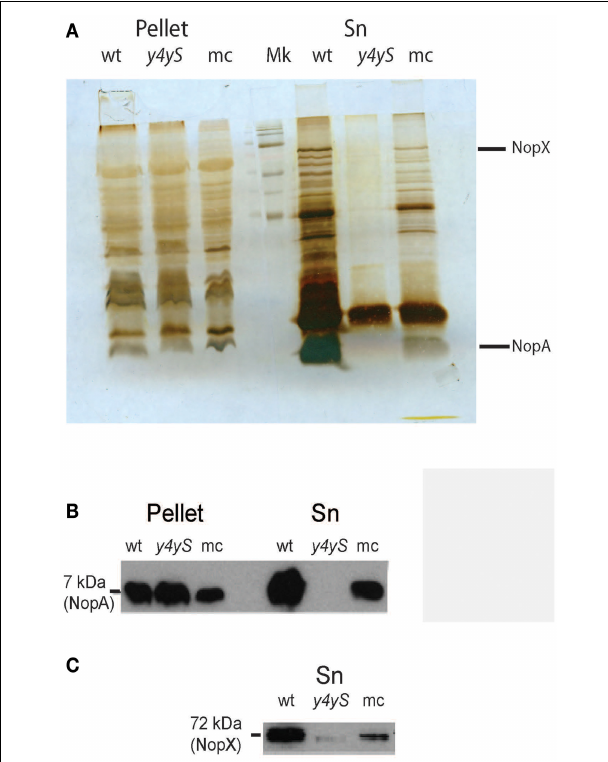
FIGURE 3 | Analysis of T3SS secreted proteins in the wild-type, y4yS mutant, and y4yS mutant complemented strains. Supernatant (Sn) and intracellular proteins (pellet) were isolated from MAFF303099 (wt), its y4yS mutant ( y4yS ), and the mutant complemented with a plasmid of moderate copy number containing the full-length y4yS gene under the lac promoter (mc). Bacteria were grown in T3SS inducing conditions. All bacteria contain plasmid pMP2112. Proteins were separated by 15% SDS-PAGE, stained with silver nitrate (A) or transferred to membranes and probed with anti-NopA antibody (B) or anti-NopX antibody (C) .